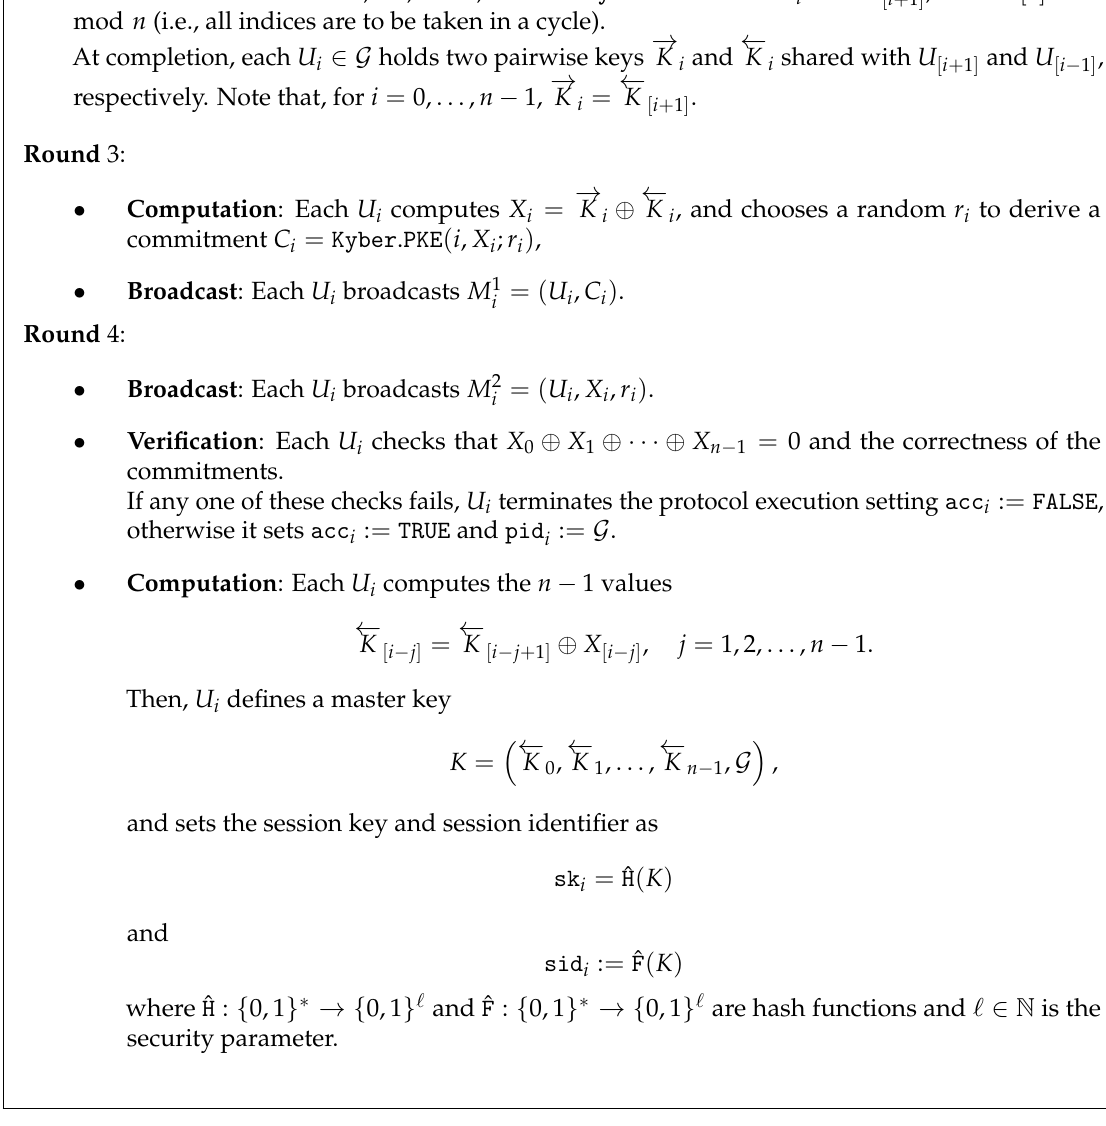
Figure 5. Proposed Post-Quantum group-key